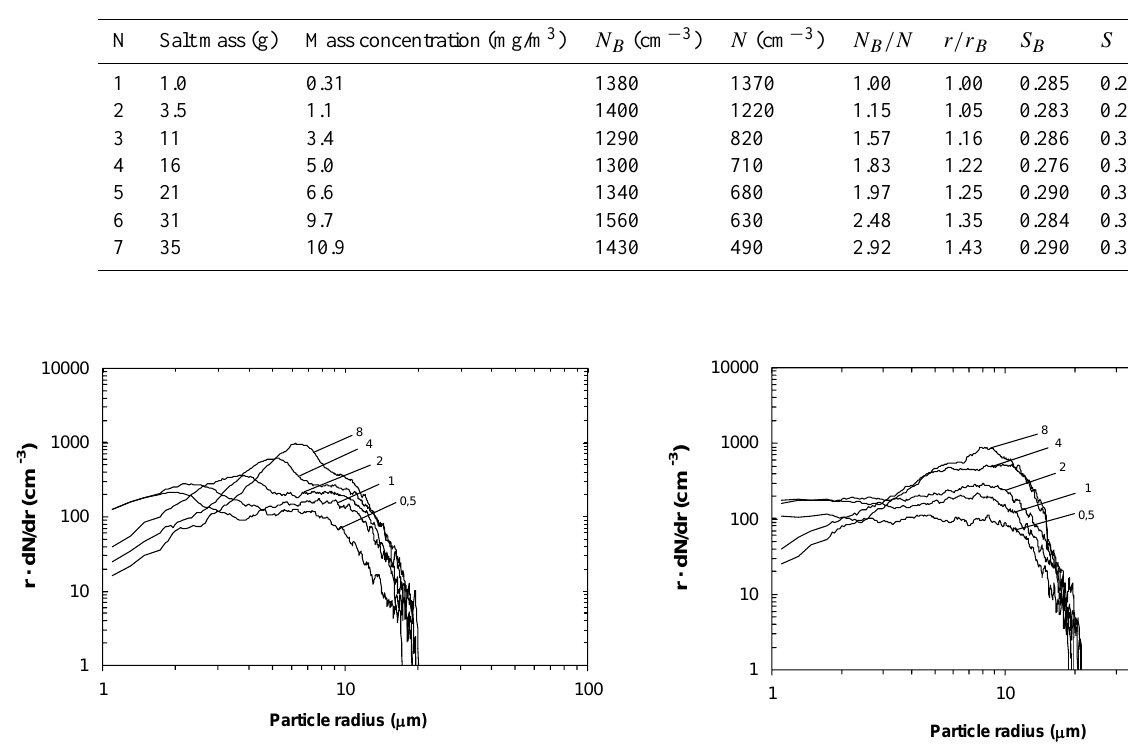
Figure 5. Observed evolution of cloud drop spectra at the introduction of salt powder into the 4 Fig. 5. Observed evolution of cloud drop spectra at the introduction BCC with the mass concentration of 5 mg/m 3 (numbers at the curves – time (min.) after the 5 of salt powder into the BCC with the mass concentration of 5mg/m 3 beginning of cloud medium formation). 6 (numbers at the curves – time (min.) after the beginning of cloud medium formation).